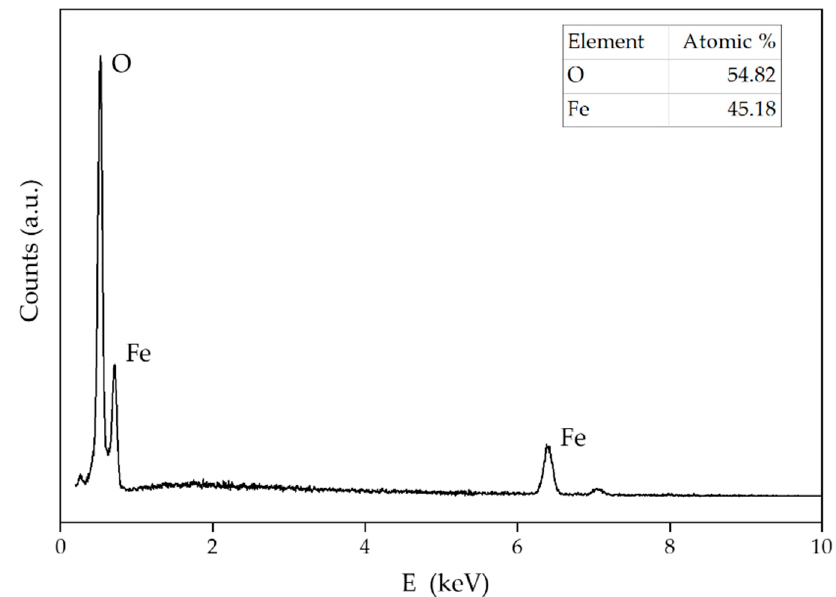
Figure 12. EDS pattern of magnetite NPs. The results of the element analysis are shown in the inset. Hematite NPs complete characterization is reported in Ref.